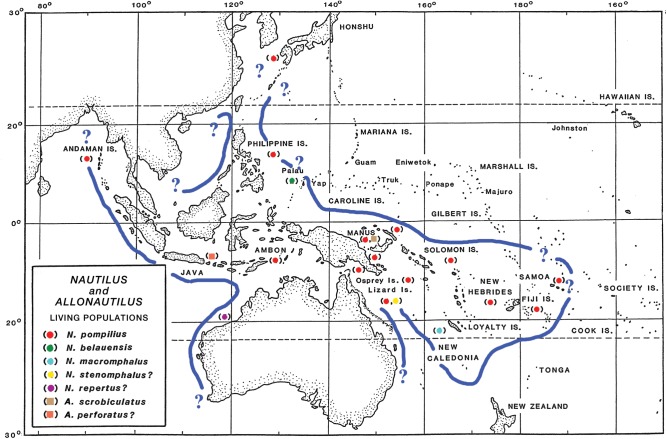
Distribution of living populations of Nautilus Linnaeus, 1758 and Allonautilus Ward and Saunders, 1997.All plotted populations were sampled for this study except A. perforatus Conrad, 1849. Nautiloids were not recovered in traps set at Yap, Caroline Is.; Pohnpei and Majuro, Marshall Is.; Kosrae, Gilbert Is.; W. Samoa; and Tonga (WBS). While such negative evidence is not definitive, it is highly suggestive that Nautilus does not occur at these sites and aids in establishing distribution limits. Modified from [10] with permission.